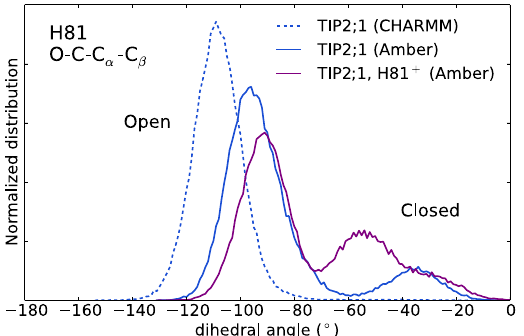
Figure 6. Distribution of H81 dihedral angle characterizing closing of the pore. The dihedral definition is indicated in the figure. Solid and dashed lines are for Amber and CHARMM, respectively. H81 + denotes that H81 is doubly protonated. Each histogram is based on one 1 μ s long trajectory. See Supplementary Fig. S2 for the corresponding